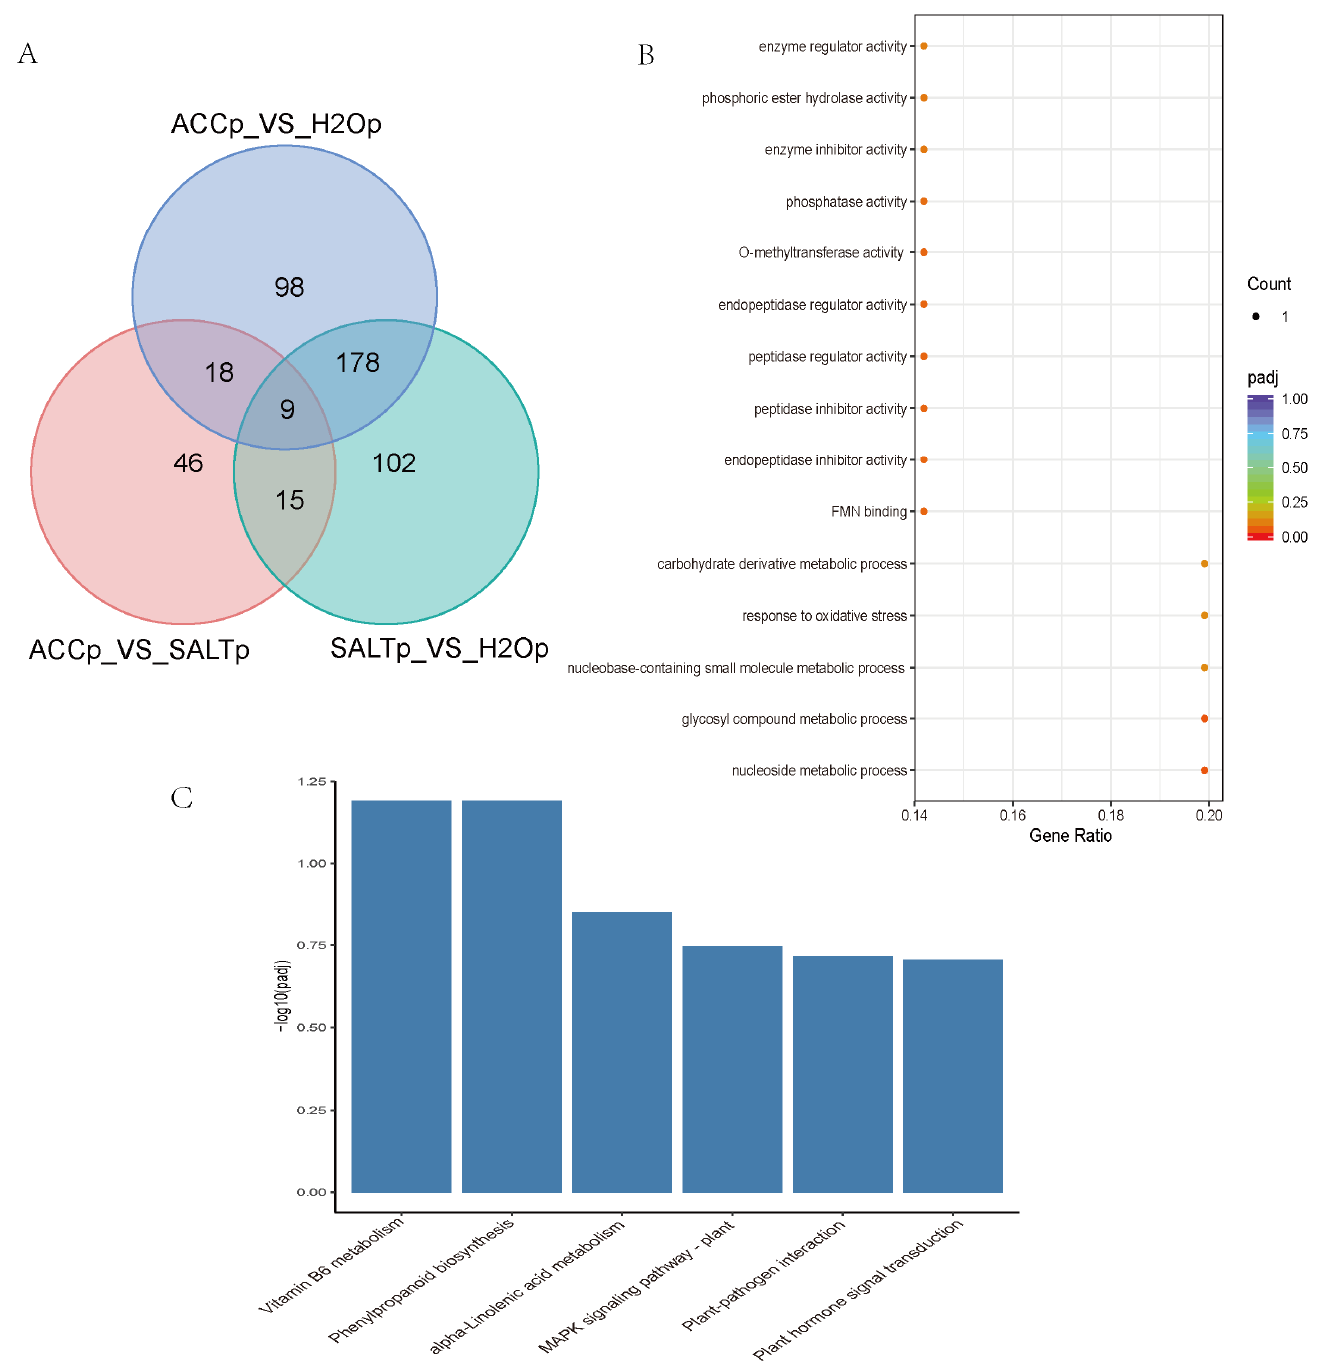
Figure 2. Multiple comparison of H2Op-vs-SALTp, H2Op-vs-ACCp, and SALTp-vs-ACCp. ( A ) Venn diagrams of DEPs in multiple comparison. ( B ) GO enriched scatter plot of DEPs in ethylene and salt responses of quinoa. Rich factor refers to the ratio of the gene number enriched in the pathway to the number of annotated genes. The bigger the Rich factor, the more significant the enrichment is. The padj value is the corrected p -value after multiple hypotheses testing, which ranges from 0 to 1. The closer to zero, the more significant the enrichment is. ( C ) The top 20 KEGG enrichment analysis of DEPs in ethylene and salt responses of quinoa. The Y-axis indicates the number of DEPs, and the X-axis shows the processes/components in different functions.